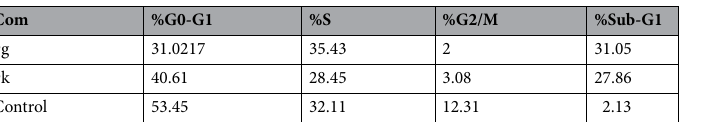
Table 3. Influence of pyrazole-thiazol-4-one hybrids 9g and 9k on the cell cycle phases of MDA-MB-231